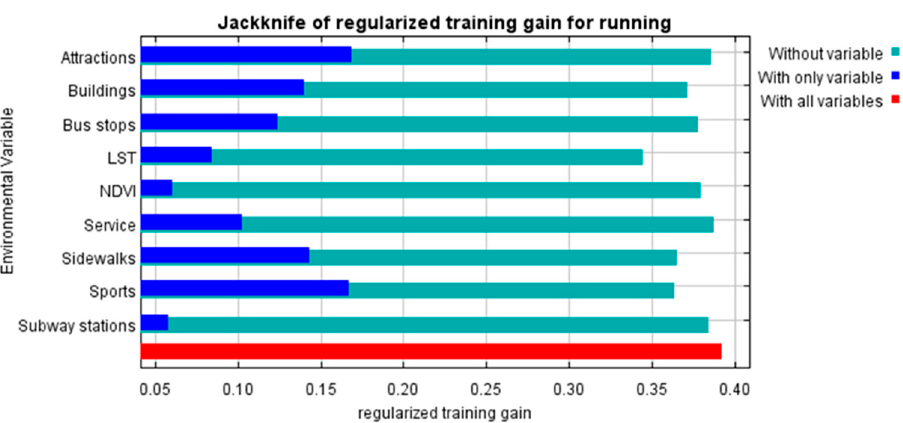
Figure 6. Jackknife of regularized training gain for running.